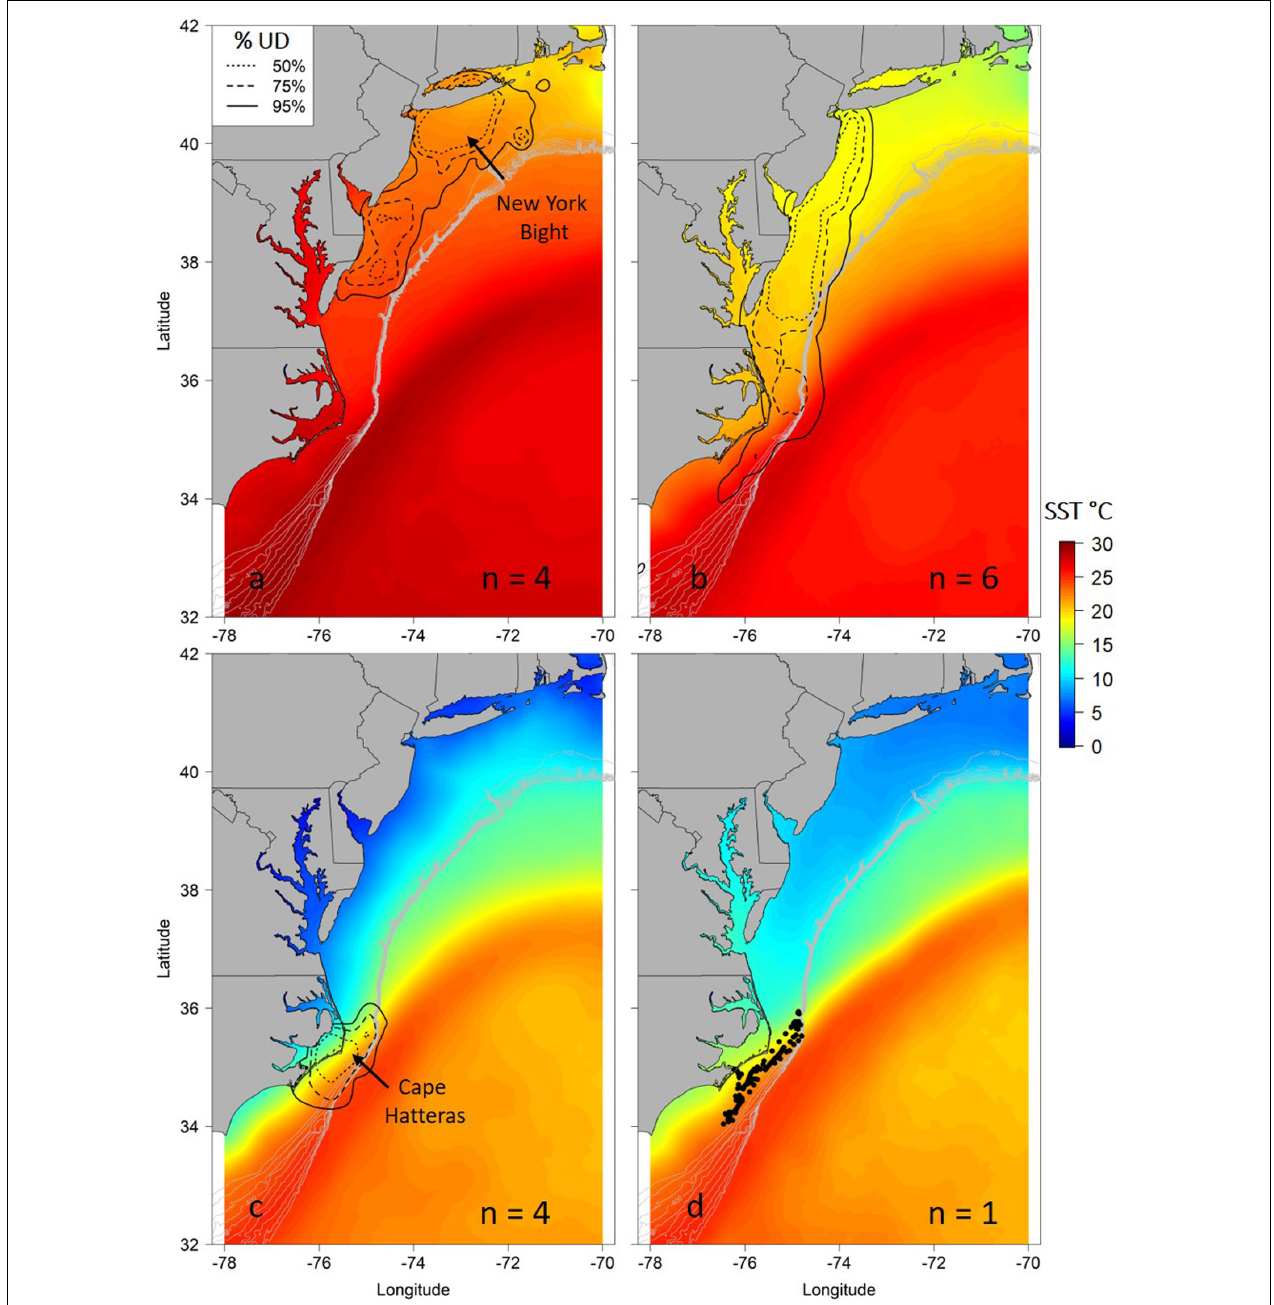
FIGURE 2 | Seasonal utilization distributions (UD) for juvenile smooth hammerhead sharks overlaid on mean seasonal sea surface temperature (SST) during the tracking period. Seasons are summer ( a ; June–August), autumn ( b ; September–November), winter ( c ; December–February) and spring ( d ; March–May). Solid line is the 95% UD, dashed line is the 75% UD and dotted line is the 50% UD. N refers to the number of individuals that were analyzed in each season. Because only one individual represents the spring locations, points of locations are shown. Gray contour lines represent depth contours from 100 to 1000 m